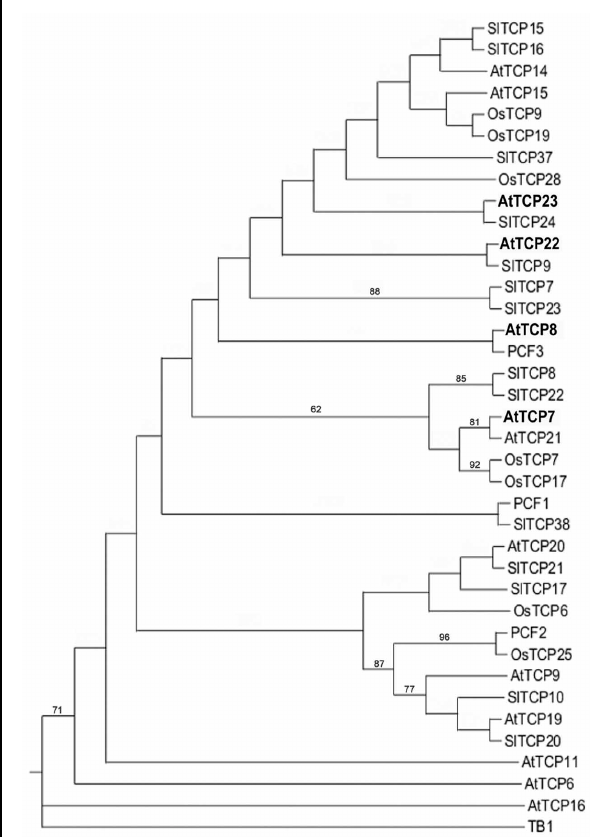
FIGURE 1 | Phylogenetic tree of class I TCP genes. Phylogenetic tree of class I TCP proteins from Arabidopsis, tomato, and rice. Protein sequences were analyzed with the maximum-likelihood method by MEGA 5 software. Bootstrap values after 1000 replicates higher than 50% are shown. The tree was rooted using the translated sequence of the maize teosinte-branched1 ( tb1 ) gene as outgroup. In bold letters are the genes analyzed in this